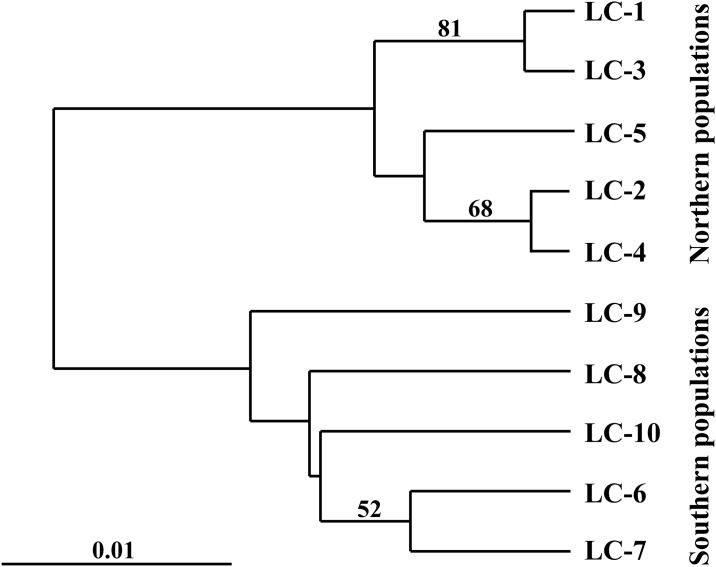
UPGMA phenogram based on Nei et al. [50] genetic distances between populations of Lilium cernuum.Note that LC-1 to LC-5 are from NE China, whereas LC-6 to LC-10 are from South Korea. Bootstrap values greater than 50% from 1000 replicates were found only for three branches.